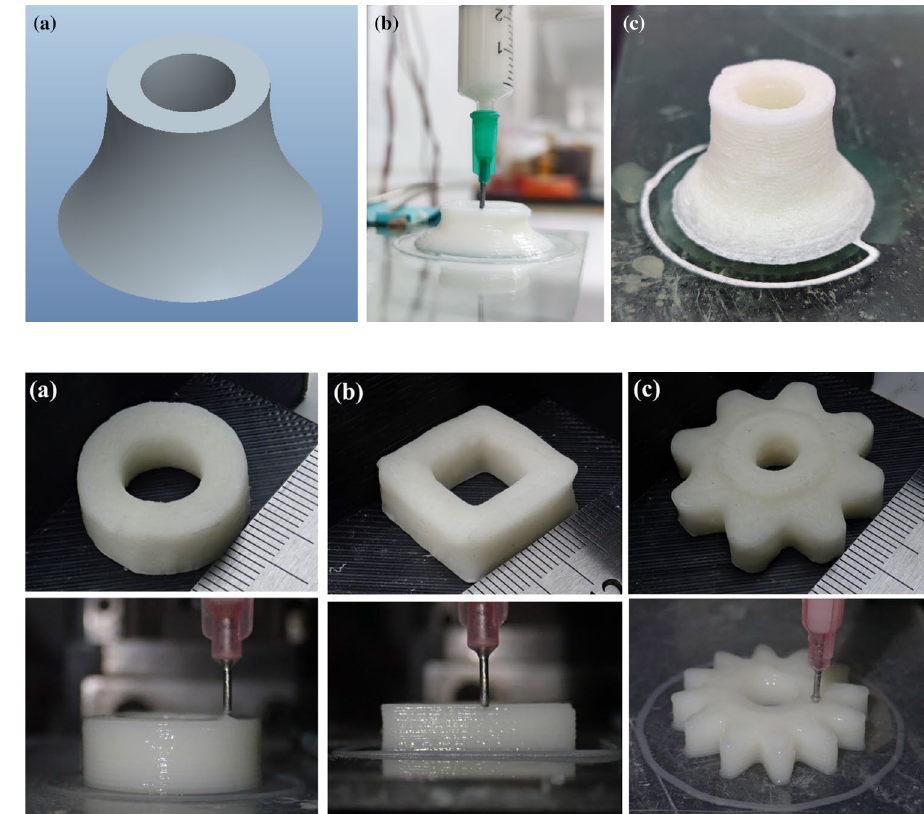
Fig. 5 CAD model, 3D printing process, and ice pattern of the cone part. a CAD model; b 3D printing process; c prepared ice pattern